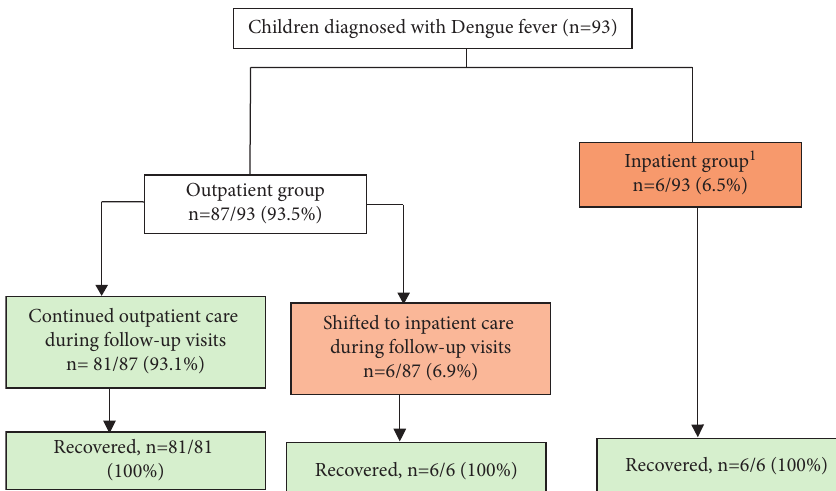
Figure 1: Flowchart of management and outcome of enrolled patients. Six patients were enrolled in the inpatient group on admission, and later on six patients from the outpatient group deteriorated and were shifted to the inpatient group. 1 All these children had severe dengue, according to WHO criteria at presentation. Of these, 2 (33.3%) had severe bleeding with hypotension and 4 (66.7%) had signs of fluid accumulation and